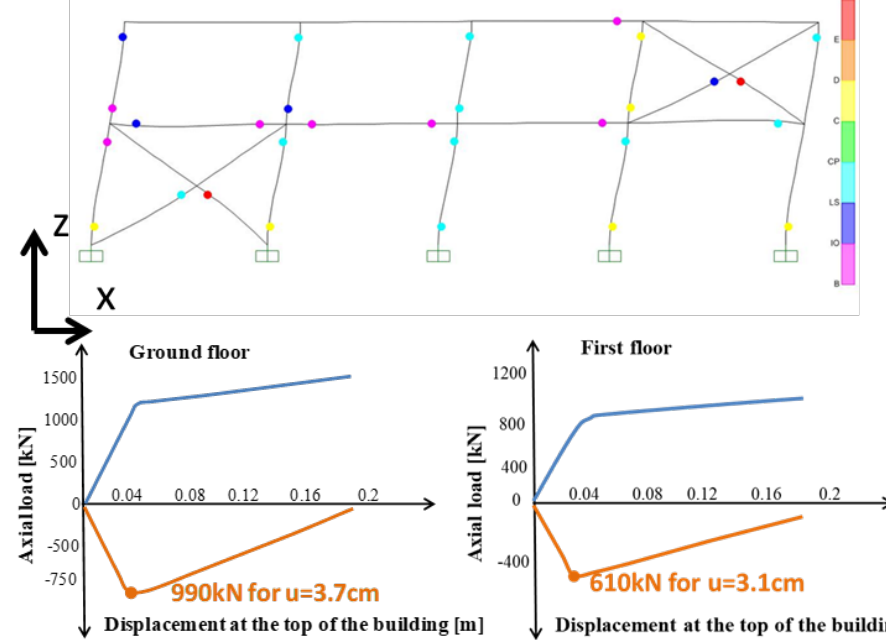
Figure 10. Plastic hinges of RD1 without the installation of CAR1 dampers for a displacement level of 18.4 cm, and axial load–displacement curves for the steel diagonal braces. 284